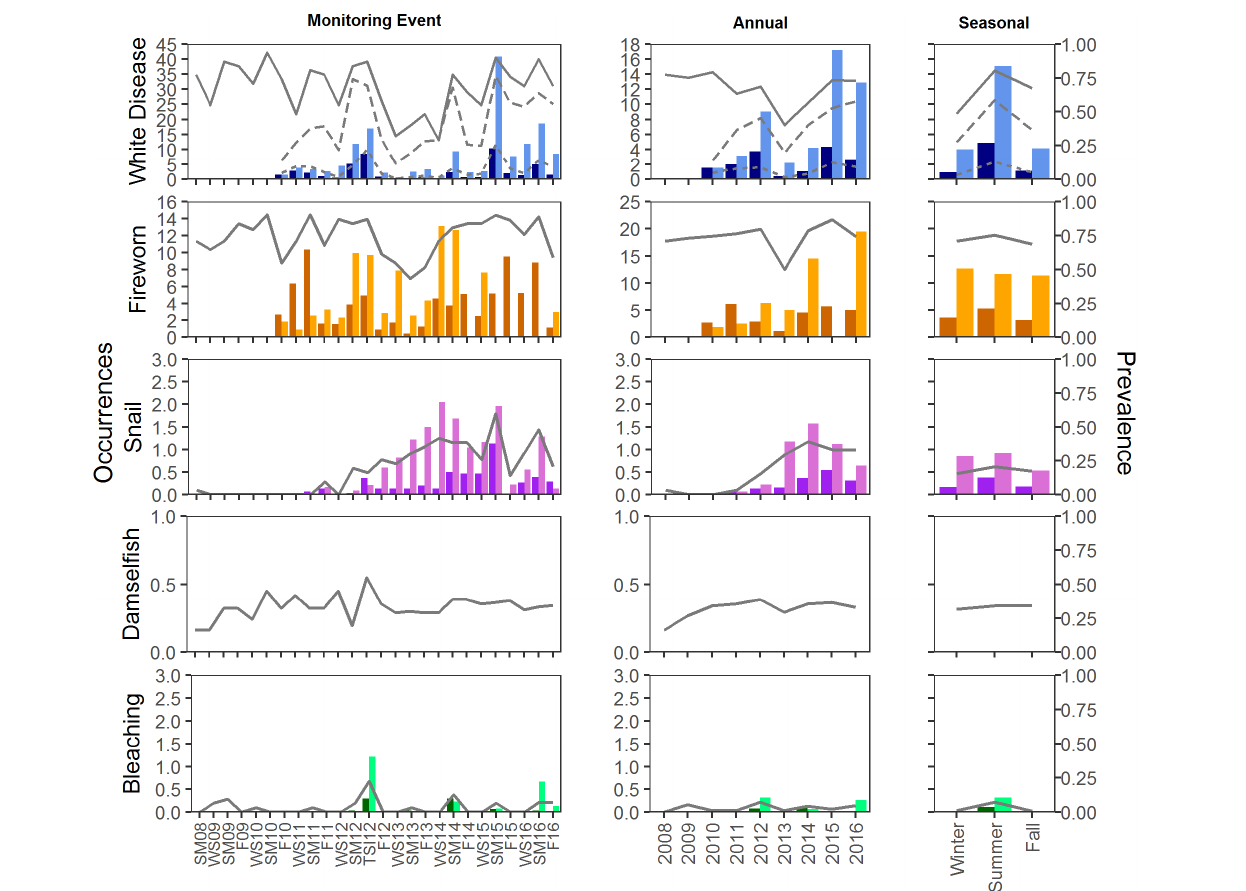
FIGURE 6 | Mean prevalence and occurrence of disease, predation, and bleaching by plot at Scooter. Prevalence is indicated by the lines on each graph; solid lines represent prevalence of plots with condition. For disease, dotted and dashed lines represent prevalence on colonies and masses, respectively. Occurrences of each condition were counted on colonies (dark bars) and masses (light bars). Occurrences were not counted for Damselfish